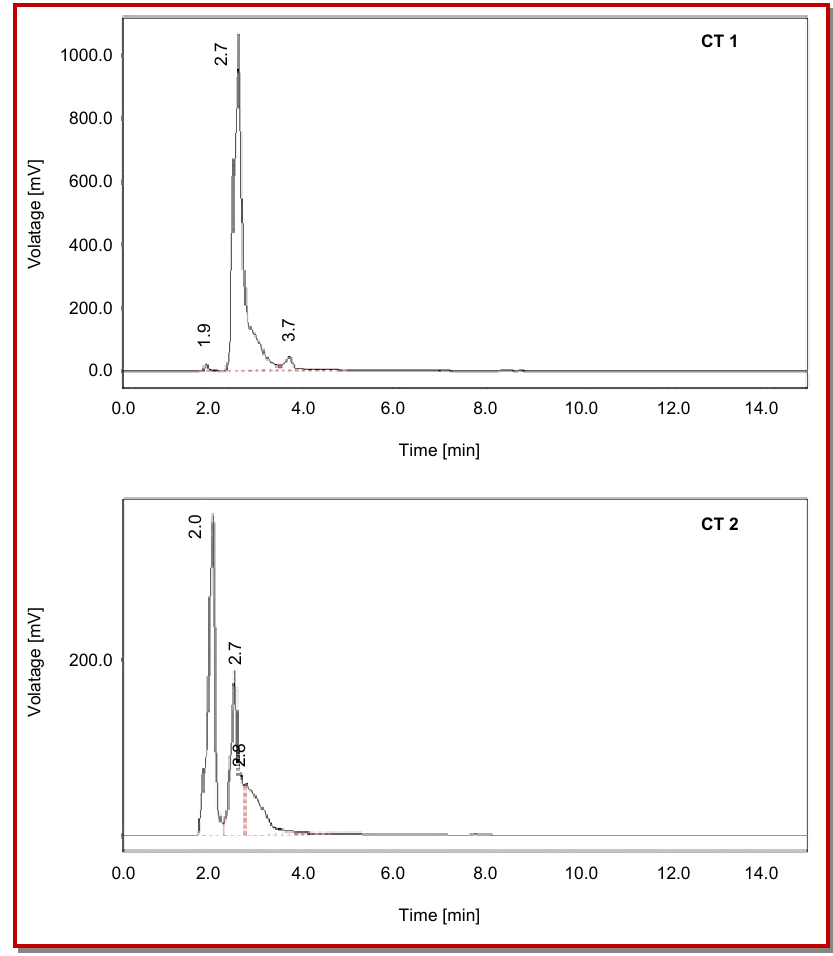
Figure 2: HPLC analysis of ethanol extract of Trichodesma sedgwickianum CA1- Chromatogram of standard catechin; CA2- Chromatogram of catechin in